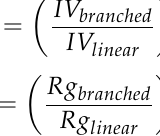
Figure 8. Diagram of branching number vs. log molecular weight for polyethylenes.